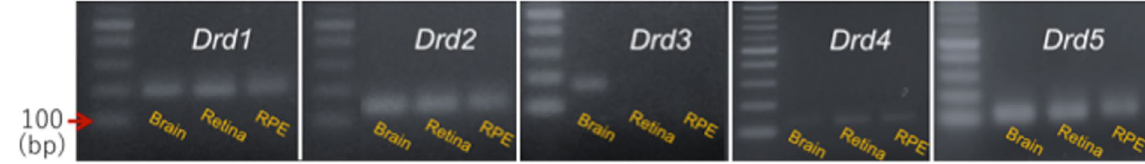
Figure 2. Expression of dopamine receptors in the brain, retina, and RPE. Agarose gel electrophoresis of PCR amplicons specific to D 1 R, D 2 R, D 3 R, D 4 R or D 5 R transcripts in brain, retina and RPE. D 3 R mRNA was present in the brain (positive control), but was not amplified in the retina (negative control) or RPE. The electrophoresis bands matched the expected amplicon